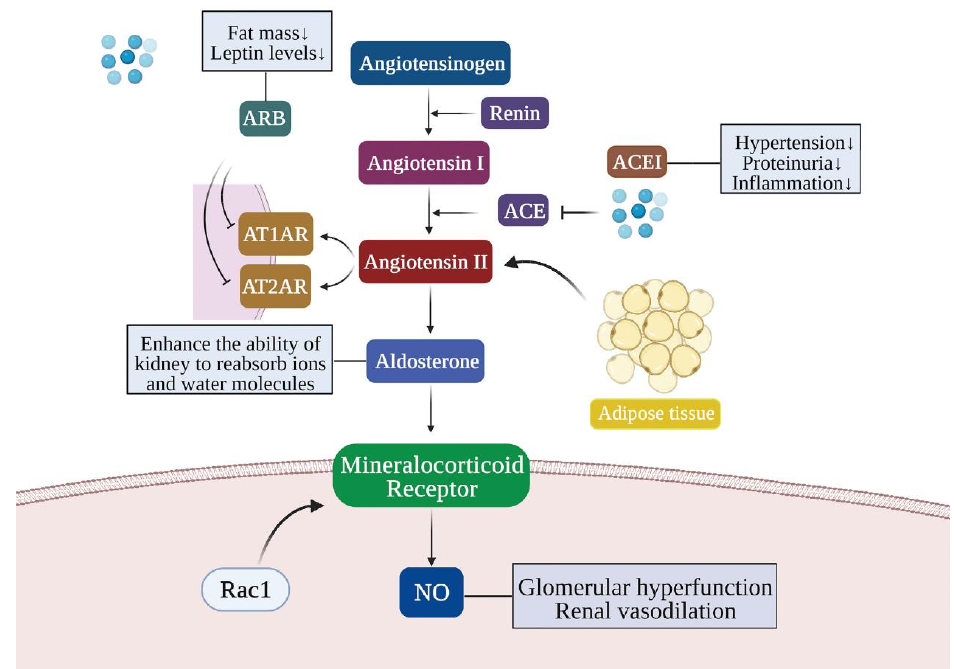
Figure 5. The role of the RAAS system and RAAS inhibitors in obesity-related kidney injury. The renin–angiotensin–aldosterone system (RAAS) is comprised of a series of peptide hormones and corresponding enzymes and is a significant humoral regulatory system. Renin secreted by renal juxta- glomerular cells can convert the angiotensinogen in the blood into angiotensin I without physiological activity. Angiotensin I forms angiotensin II under the action of an angiotensin-converting enzyme (ACE). Adipose tissue can promote the secretion of angiotensin II, which stimulates the secretion of aldosterone and promotes the reabsorption of water and sodium in renal tubules, improves the renal filtration rate and causes proteinuria. Aldosterone stimulates NO synthesis through the mineralo- corticoid receptor (MR) or Rac1, which leads to glomerular hyperfunction, renal vasodilation and renal injury. RAAS inhibitors, ARB and ACEI correct the renal filtration efficiency by inhibiting the corresponding substance level in the RAAS system, and then alleviate renal injury. ACE, angiotensin converting enzyme; ACEI, angiotensin converting enzyme inhibitors; ARB, angiotensin receptor blocker; AT1AR, angiotensin type 1A receptor; AT2AR, angiotensin type 2A receptor; NO, nitrogen oxide; Rac1, ras-related C3 botulinum toxin substrate 1. “ ↓ ” represents a